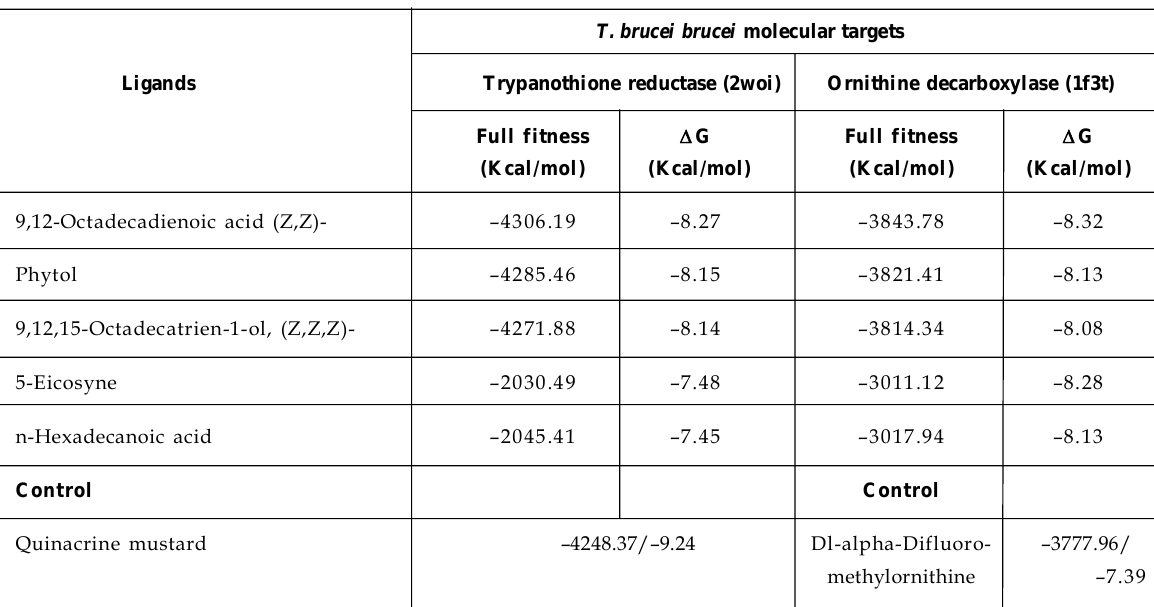
Table 7: Docking result of T. brucei brucei molecular drug targets